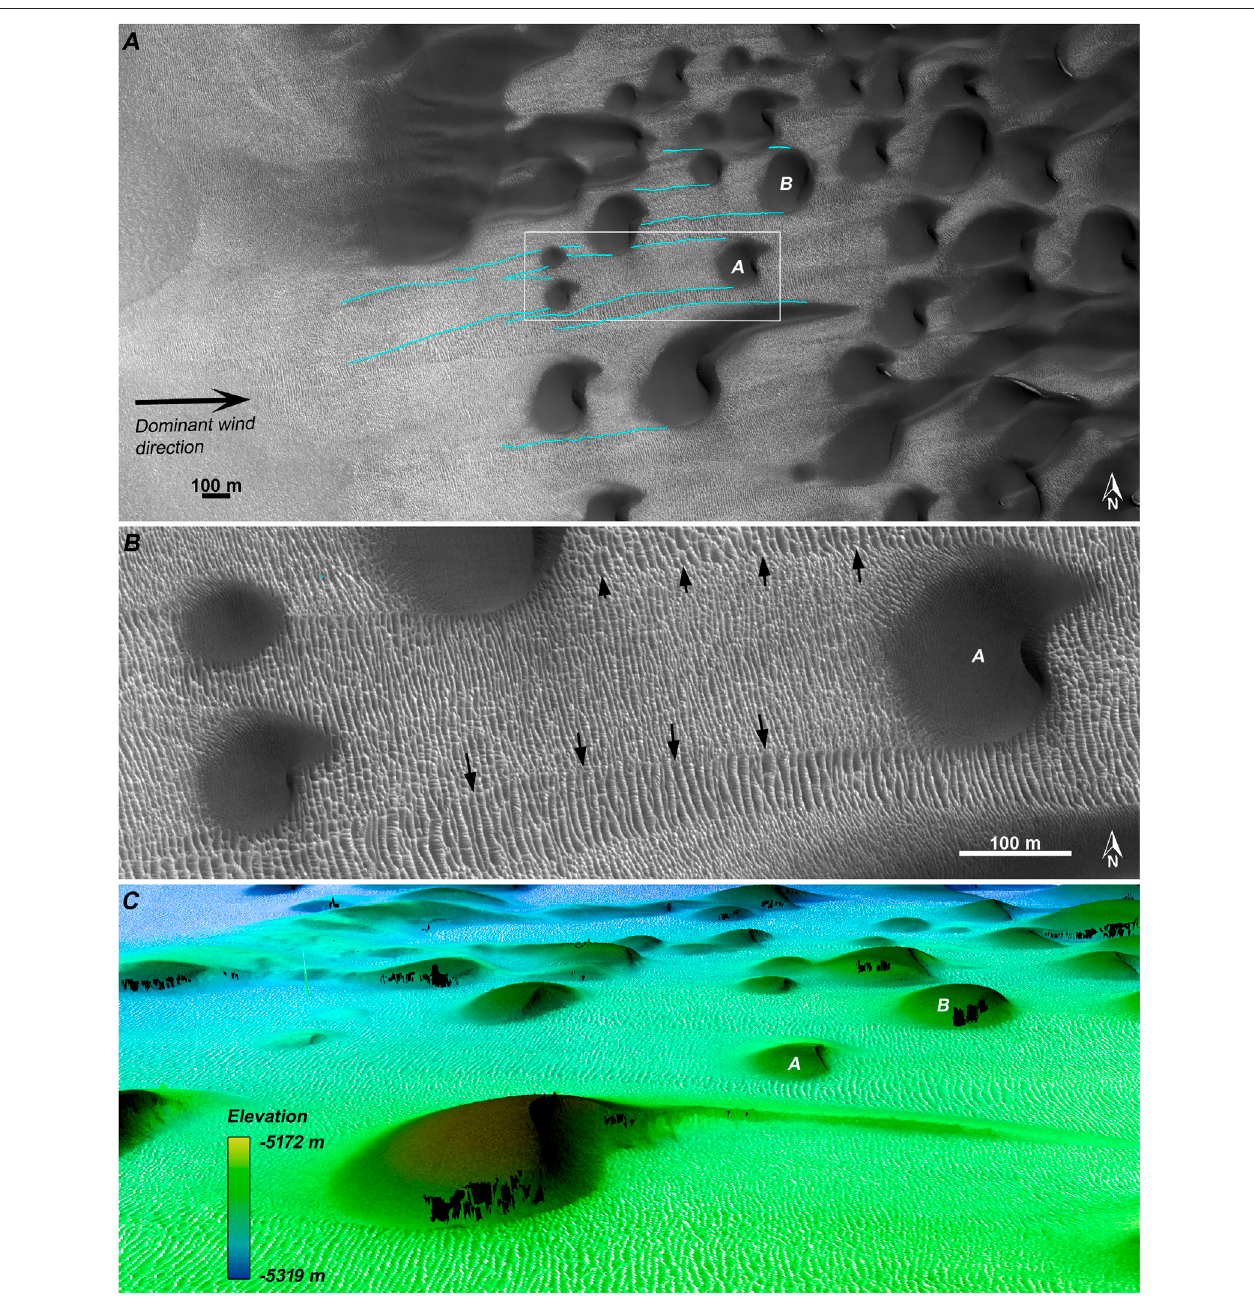
FIGURE 1 | TAR- fi lled wakes made by migrating barchans (HiRISE ESP_017426_2570). (A) The western margin of the dune fi eld, with barchans and barchanoid dunes trailing wakes. Studied dunes are labeled as A and B; the white box shows the location of (B) the wake stretching upwind of Dune A . The barchan ’ s passage leaves behind a relatively disorganized bedform pattern, contrasting with the surrounding TAR pattern (black arrows indicate locations along the wake margins), and appearing to mature with distance upwind of the dune (i.e., over time). (C) Perspective view of the study dunes made from the constructed DTM (black areas indicate pixels that did not co-register because of dune activity; the view is vertically exaggerated by 2x).